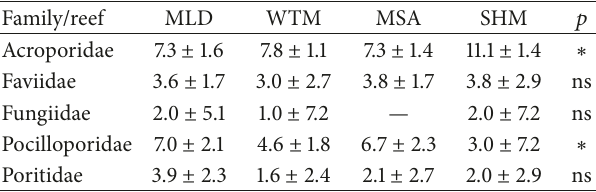
Table 3: Percent algal abundance (type and phylum) on experimen- tal tiles and natural substrates from four Kenyan protected coral reef lagoons including ANOVA test.